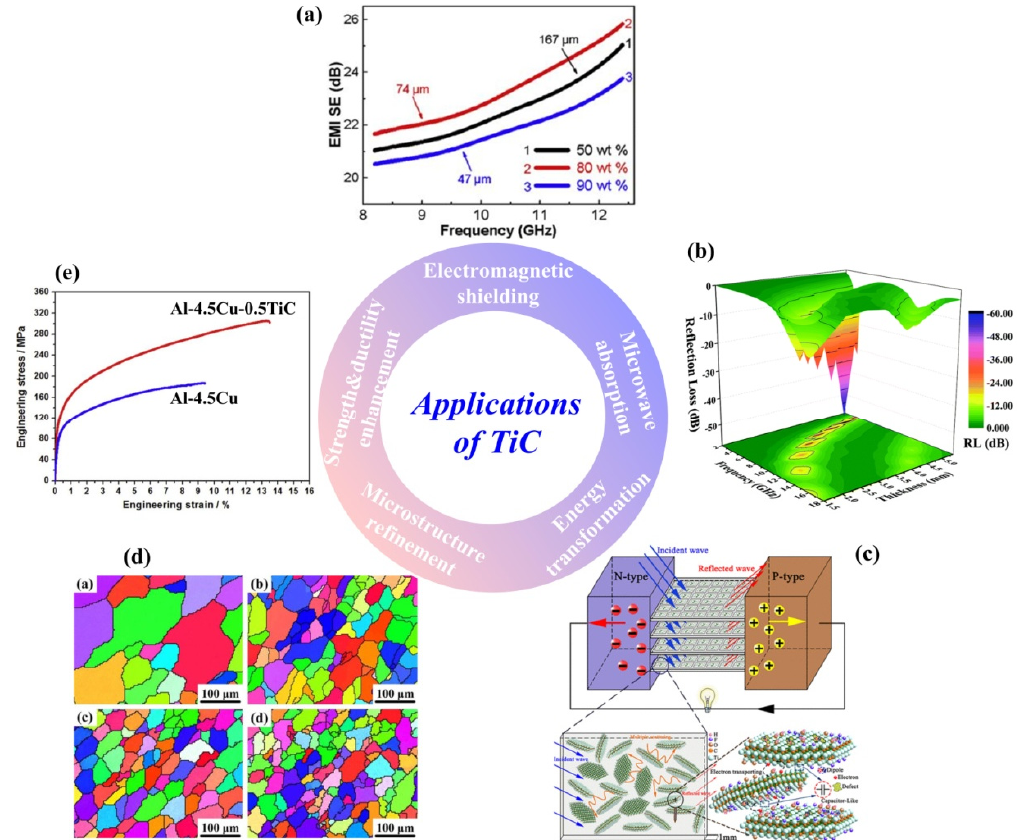
Figure 2. Various applications of titanium carbides nanostructures. ( a ) Electromagnetic shielding. With permission from Reference [28], copyright (2018) American Chemical Society. ( b ) Microwave absorption. With permission from Reference [3], copyright (2018) Royal Society of Chemistry. ( c ) Energy transformation. With permission from Reference [25], copyright (2010) Royal Society of Chemistry ( d ) Microstructure refinement. With permission from Reference [29], copyright (2018)